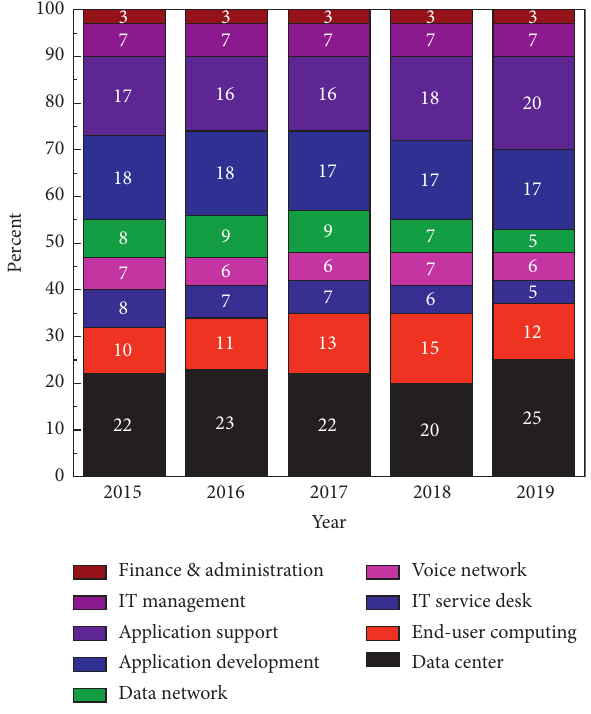
Figure 7: Distribution of IT costs.